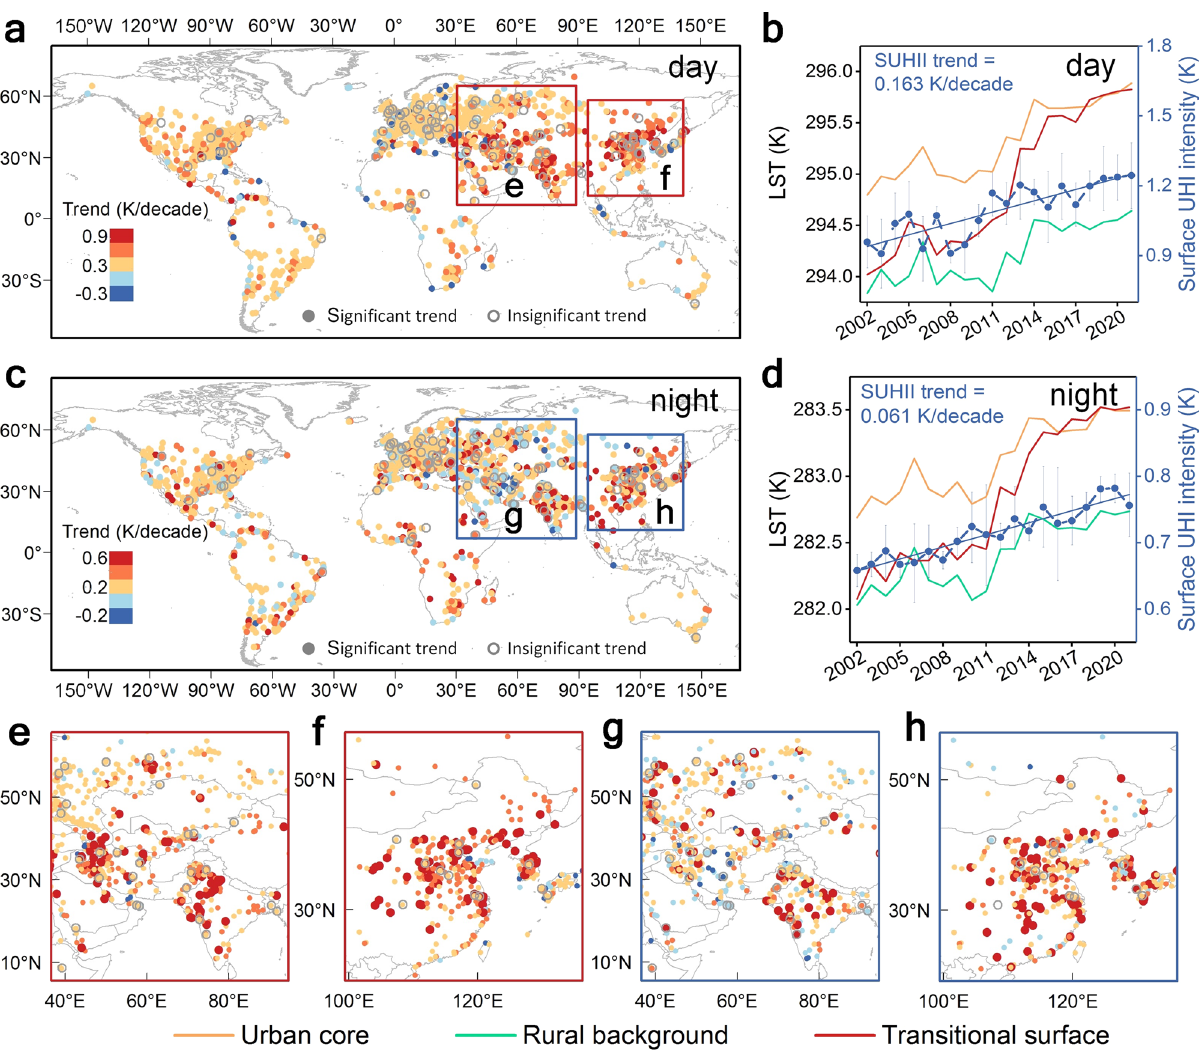
Fig. 1 Surface warming trends at the urban core across the world. Map of daytime trend ( a ), map of nighttime trend ( c ), and global mean trend in daytime ( b ), and nighttime surface UHI intensity ( d ). The two boxed regions in a , c are enlarged as e , f for daytime and g , h for nighttime. Note that the error bars represent 10%~90%